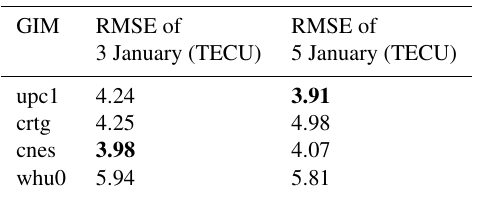
Table 5. RMSE of RT-GIMs in RT-dSTEC assessment on 3 and 5 January 2021.